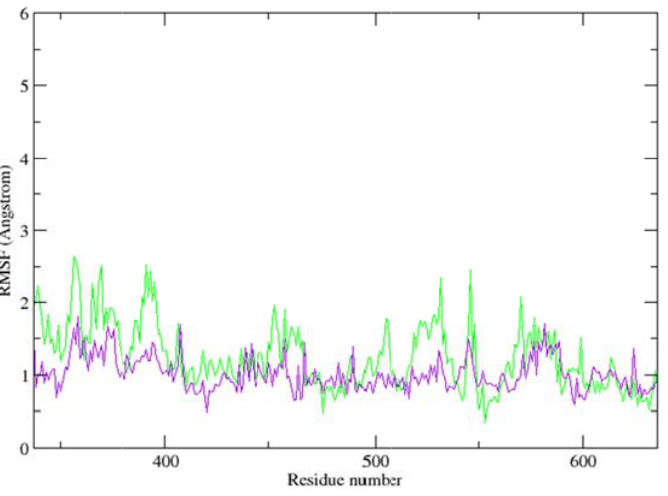
e 12. The R and Va am3-bound